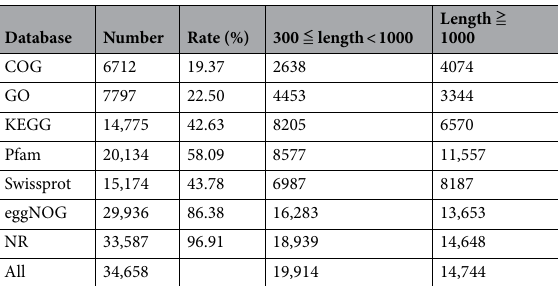
Table 3. Functional annotation of the A. dissimilis transcriptomes.